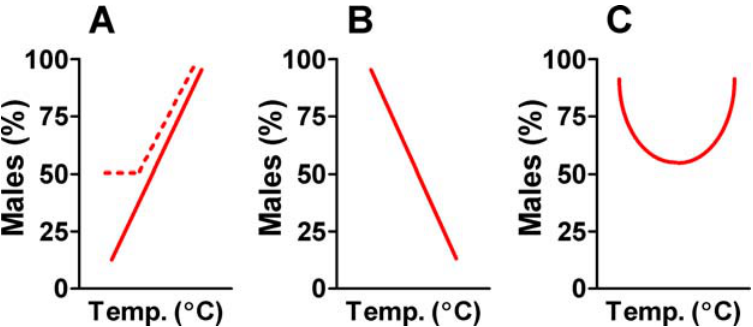
Figure 1. Patterns of temperature-dependent sex determination (TSD) in fish that had been recognized to date. They are defined according to the sex ratio produced as a function of temperature during the thermosensitive period. A , Pattern 1, low temperatures produce female- biased sex ratios and high temperatures produce male-biased sex ratios. B , Pattern 2, low temperatures produce male-biased sex ratios and high temperatures produce female-biased sex ratios. C , Pattern 3, male-biased sex ratios are produced at low and high temperatures, while balanced sex ratios are produced at intermediate temperatures. In some cases, the response may be partial (dashed line in A). The present study demonstrates that fish species with TSD only exhibit pattern